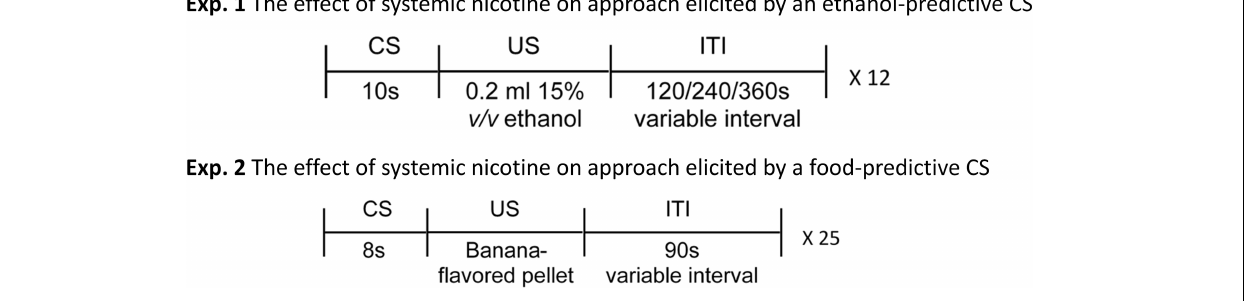
FIGURE 1 | Diagram of the experimental design for experiments 1 and 2. In experiment 1, the 10-s extension of an illuminated lever (CS) predicted the delivery of 0.2 mL ethanol (15% vol/vol; US) into a receptacle. There were 12 CS–US trials, and each trial was separated by an intertrial interval (ITI) of either 120, 240, or 360 s. Rats received an injection of either nicotine (0.4 mL/kg s.c.) or saline 15 min prior to each session. In experiment 2, the 8-s extension of an illuminated lever (CS) predicted the receipt of a single banana-flavored food pellet (US) into a receptacle. There were 25 CS–US trials, and each trial was separated by an ITI on a 90-s (60–150 s) variable time schedule. As in experiment 1, rats in experiment 2 also received an injection of either nicotine (0.4 mL/kg s.c.) or saline 15 min prior to each